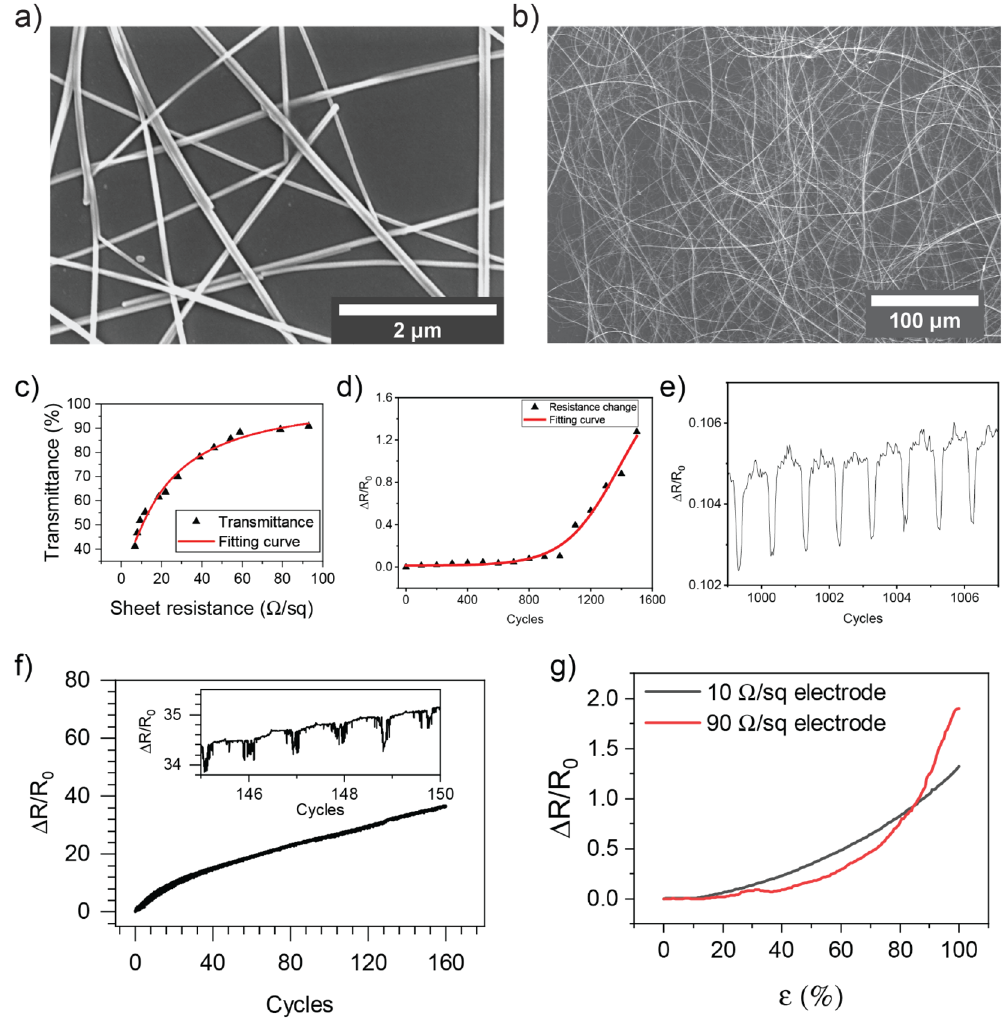
Figure 1. ( a , b ) FE-SEM images of synthesized Cu NWs on PDMS substrate with different magnifications. ( c ) Specular transmittance at a wavelength of 550 nm as a function of sheet resistance of the Cu NW electrodes. ( d ) Durability test of the Cu NW-based electrode under the strain of 30%. ( e ) Resistance change of Cu NW-based electrode at 1000th cycle under the strain of 30%. ( f ) Durability test of the Cu NW-based electrode under the strain of 100%, the inset graph shows the resistance change from 145 to 150th cycle (R 0 = 10 (cid:31) ). ( g ) Relative resistance changes under various strains of 10 and 90 (cid:31) \ sq